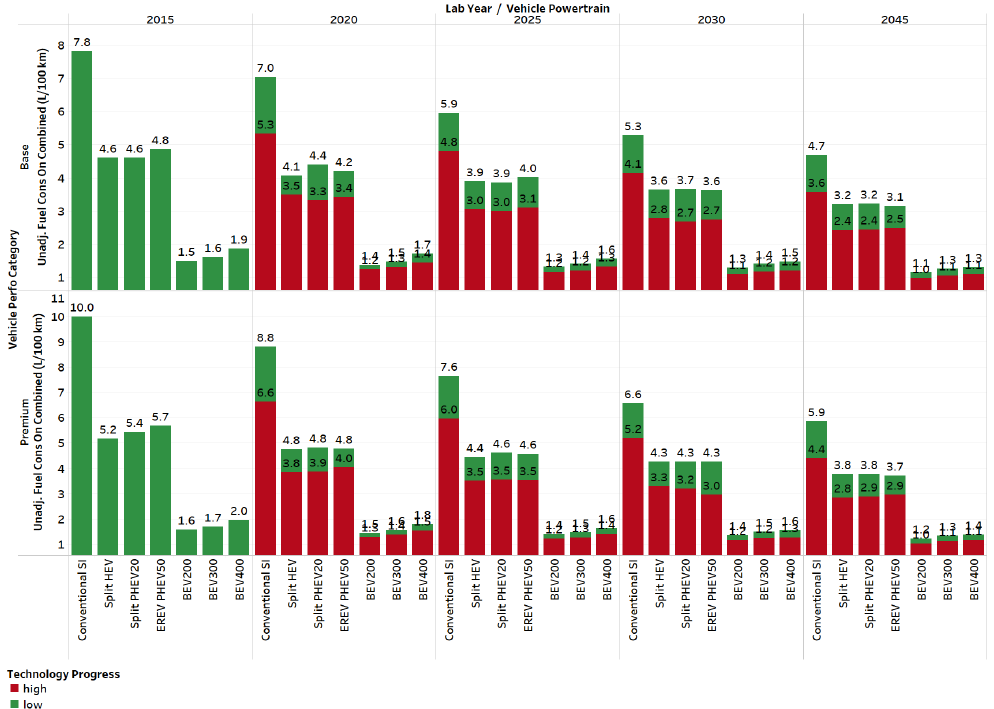
Figure 12. The gasoline-equivalent unadjusted fuel consumption of different vehicle powertrains on the combined driving